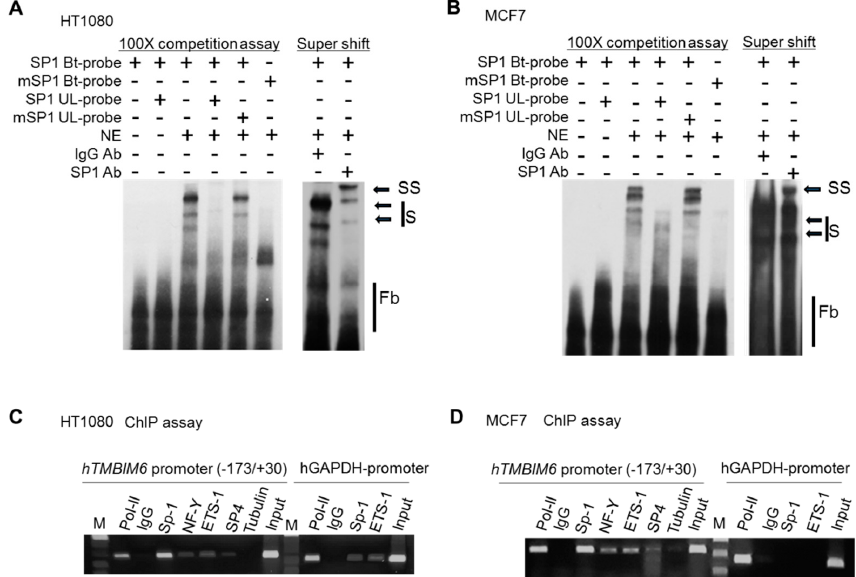
Figure 4. EMSA and ChIP assay showing Sp1 binding to the human TMBIM6 promoter. ( A , B ) Nuclear extract (NE) was prepared from HT1080 (A) and MCF7 (B) cells. Double-stranded 35-bp oligonucleotide probe specific to Sp1 proximal site ( − 25 /+ 7) was generated and labeled with biotin. The labeled Sp1-p probe was incubated alone (lane 1), with unlabeled probe (lane 2), with the NE (lane 3), with the NE and 200-fold excess amount of unlabeled homologous probe (lane 4), with 200-fold excess mutant probe (lane 5), and with mutant-labeled probe that failed to form a complex with the NE (lane 6). DNA–protein complexes that formed are indicated (S), unbound probes indicated as free probes (Fb). In lanes 7–9, the super shift assay was performed by pre-incubating the NE with probe for 20 mins on ice before adding the specific antibody. Then, the specific probe was added and further incubated for 20 mins on ice, with normal IgG as the negative control in lane 7 and anti-Sp1 monoclonal antibody in lanes 8, respectively. The super shift is indicated as SS. ( C , D ) ChIP was carried out with HT1080 ( C ) and MCF7 ( D ) cells; antibodies for RNA polymerase II (pol-II), Sp1, ETS-1, NF-Y, and SP4 were used, with tubulin and IgG as the negative control. Immunoprecipitated chromatin was amplified by PCR with primers specific to region − 173 to + 30 of the TMBIM6 gene. The GAPDH locus was used as the control. M: DNA